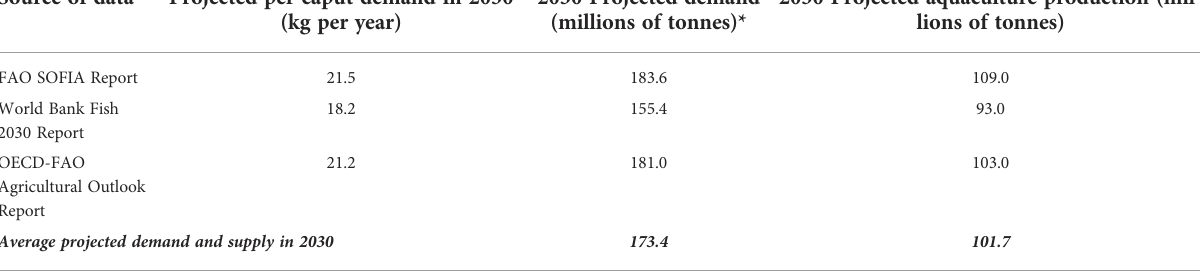
TABLE 1 Projected global per capita fi sh consumption growth rate, demand and aquaculture production. Source of